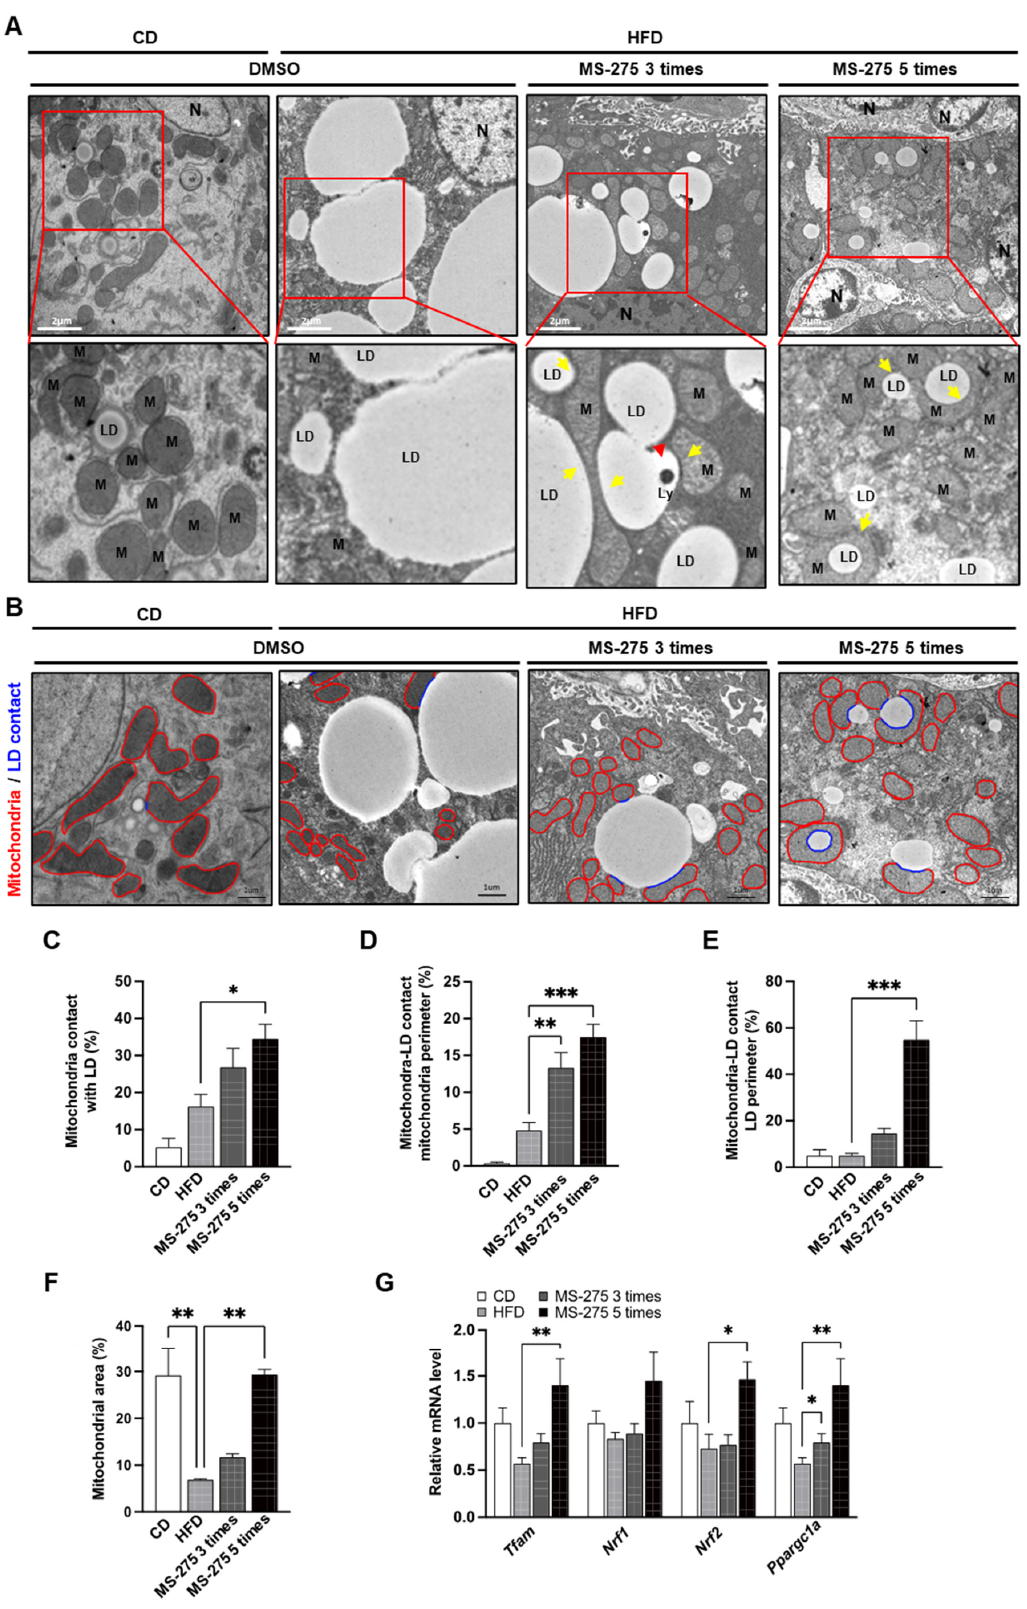
Figure 5. MS-275 increased mitochondrial content and the expression of mitochondrial biogenesis- related genes, as well as peri-lipid-droplet mitochondria in HFD-induced fatty liver. ( A ) Liver tissues isolated from mice administered MS-275 three or five times after feeding a CD or HFD for 14 weeks were observed by TEM (N, nuclei; LD, lipid droplet; M, mitochondria; Ly, lysosome;